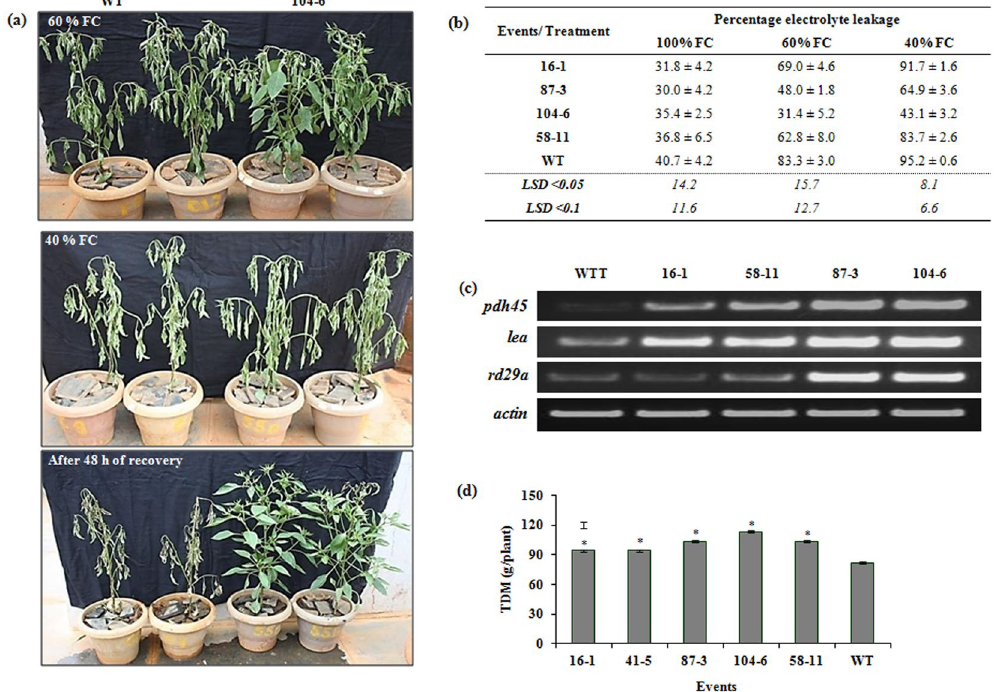
Figure 7. Response of the transgenic events to water stress at varied levels by gravimetric approach. ( a ) Drought tolerance in plants of WT and transgenic event 104-6 at 60% and 40% field capacity, and recovery response after 48 h of re-watering (100% FC); ( b ) membrane electrolyte leakage from different genotypes under well-watered and drought stress conditions; ( c ) expression of PDH45 and other drought-responsive genes at 60% FC in different genotypes; ( d ) total dry matter (TDM) after recovery from drought stress in the transgenic events and WT. (WT = wild type; WTT = wild type treated. Bars in the graph area indicate LSD value at P < 0.05; ( * ) indicates significant differences at P < 0.05).